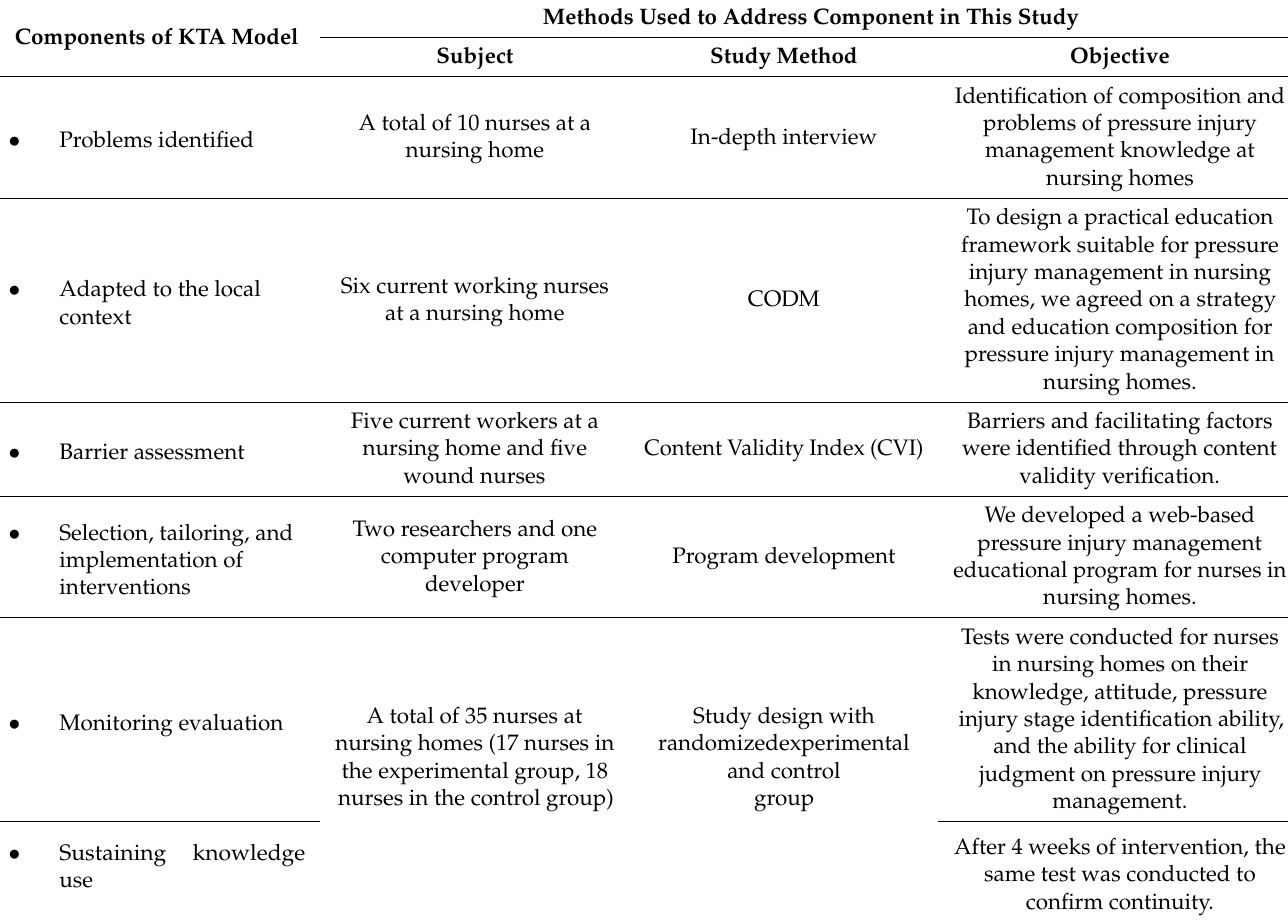
Table 1. Components of the KTA model, with methods